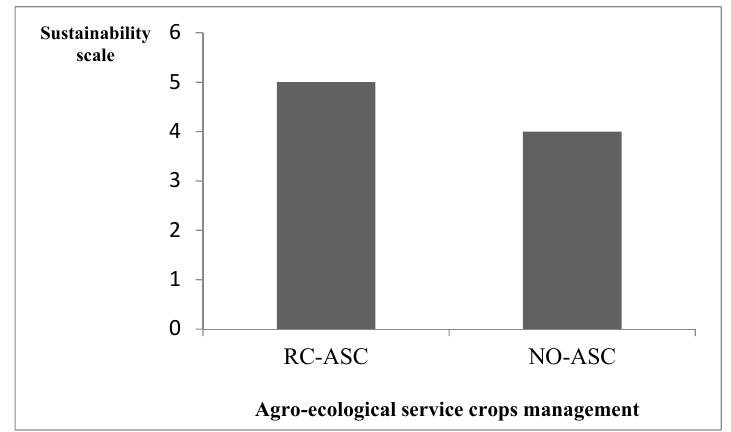
Figure 4. Comparison between the two crop managements: evaluation results of the multi-criteria decision model DEXi-met. Overall sustainability is defined as: very low = 0, low = 1, medium–low = 2, medium = 3, medium–high = 4, high = 5, very high = 6 (RC-ASC = agro-ecological service crops terminated by roller crimper; NO-ASC = no agro-ecological service crops control).